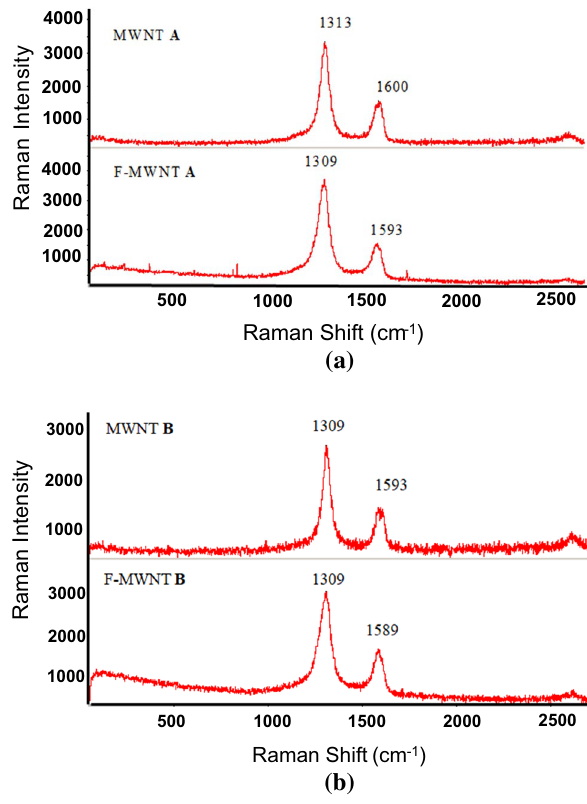
Fig. 2 Raman spectra for MWNT A and B before and after fluorina-